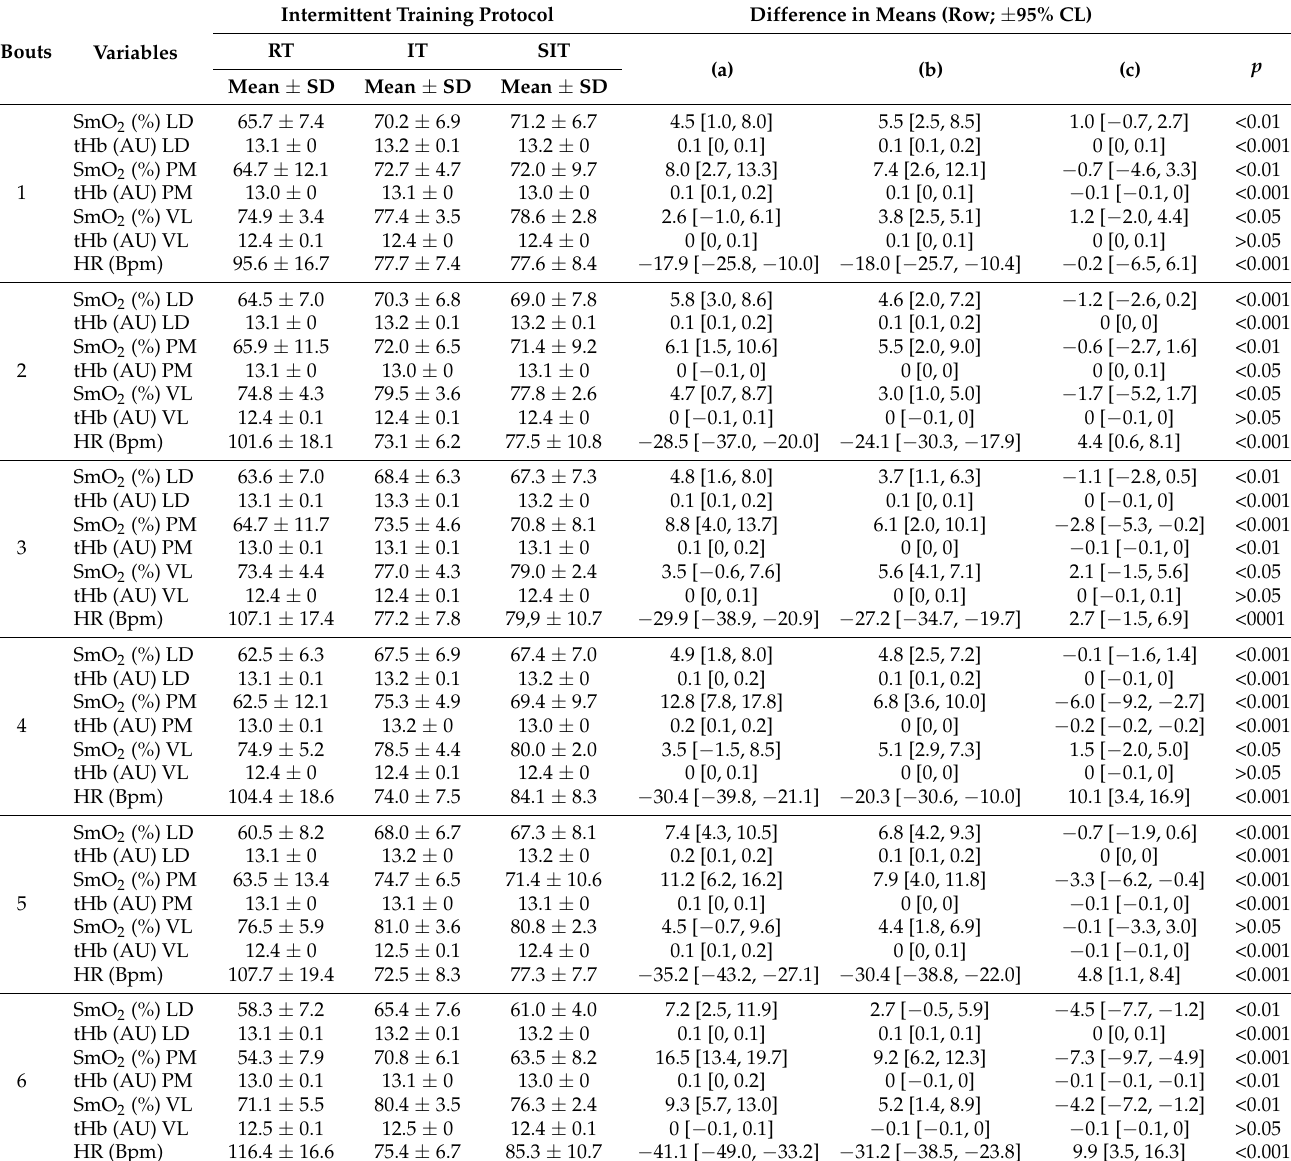
Table 4. Characterization and inferential analysis of the considered variables according to different intermittent training protocols during rest